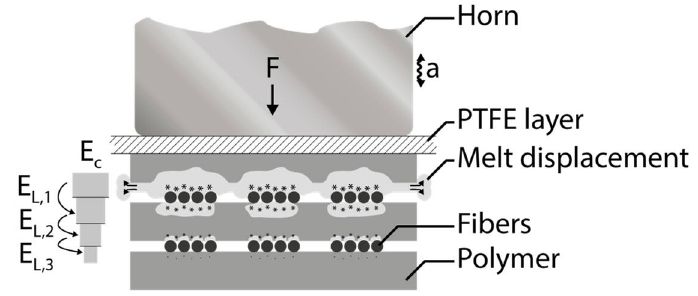
Figure 8. Illustration of energy directing effect of fibers in ultrasonic impregnation. Table 2. Resulting glass fiber contend by volume with different parameter settings; number of measurements: 3.